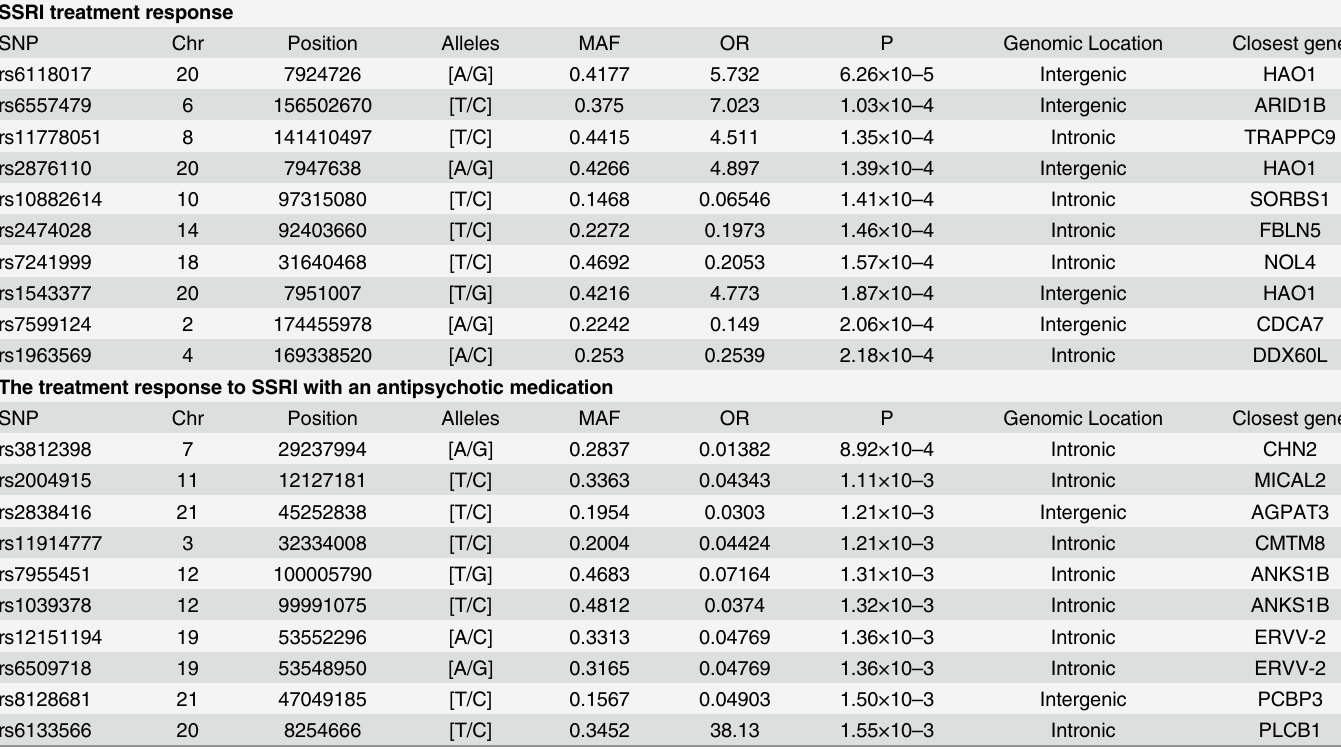
Table 2. Association results of GWAS for the treatment response in OCD.